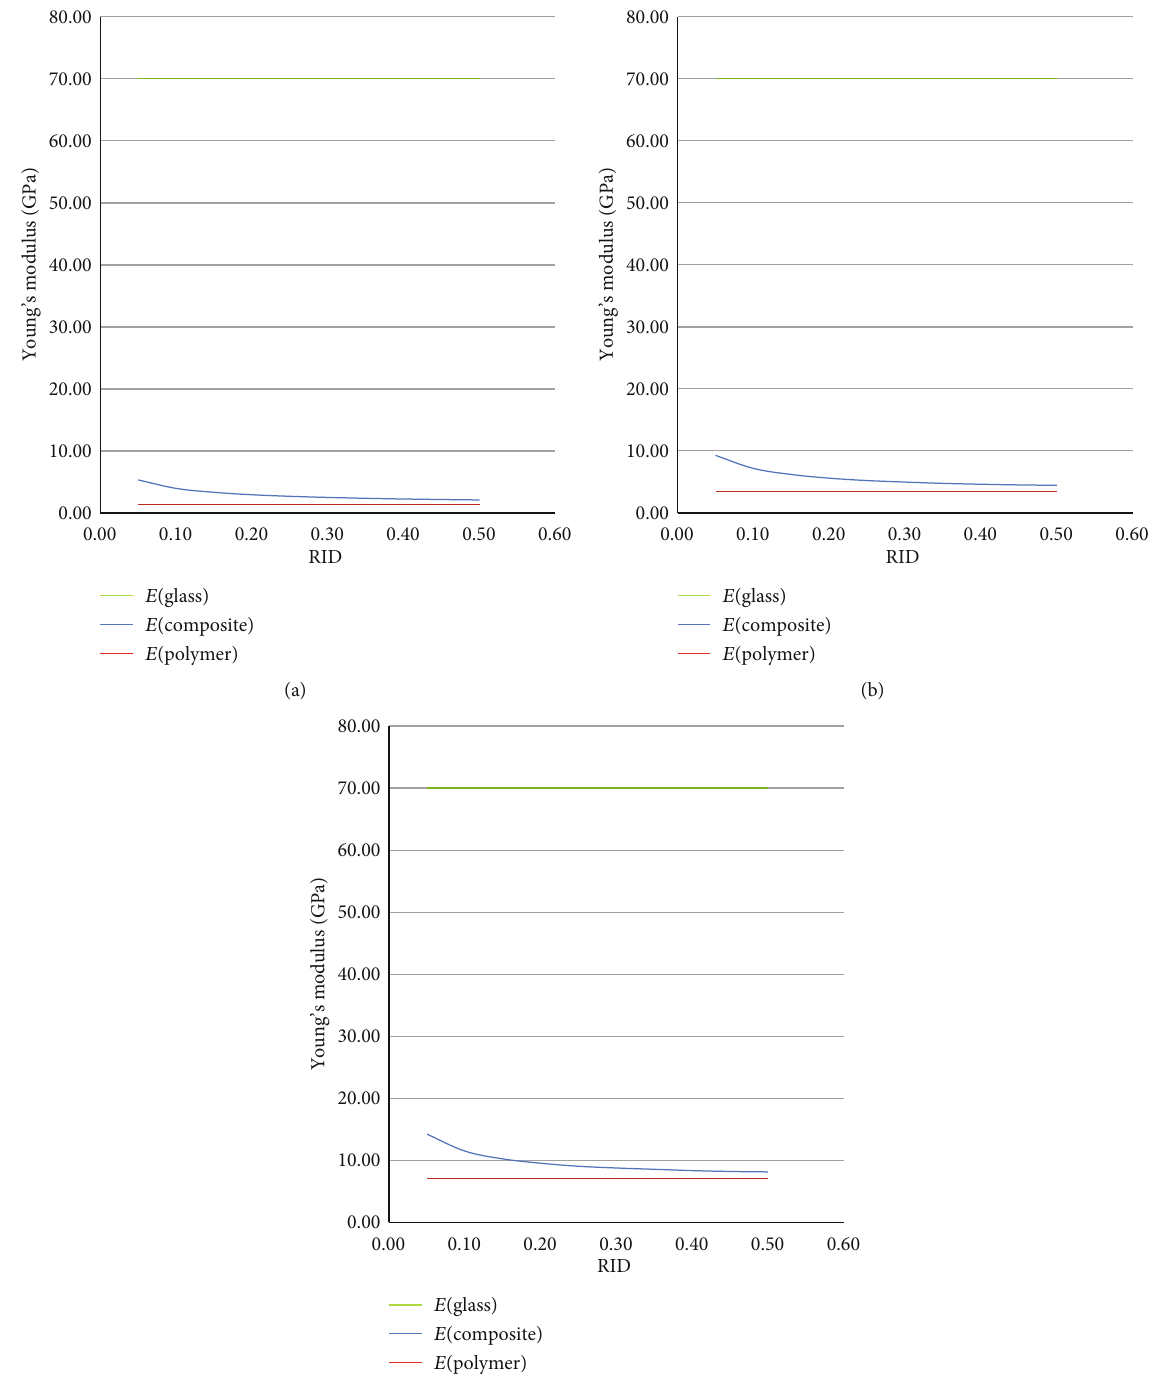
Figure 11: E (composite) changed with RID when E (substrate) is equal to (a) 1.4GPa, (b) 3.5GPa, and (c) 7